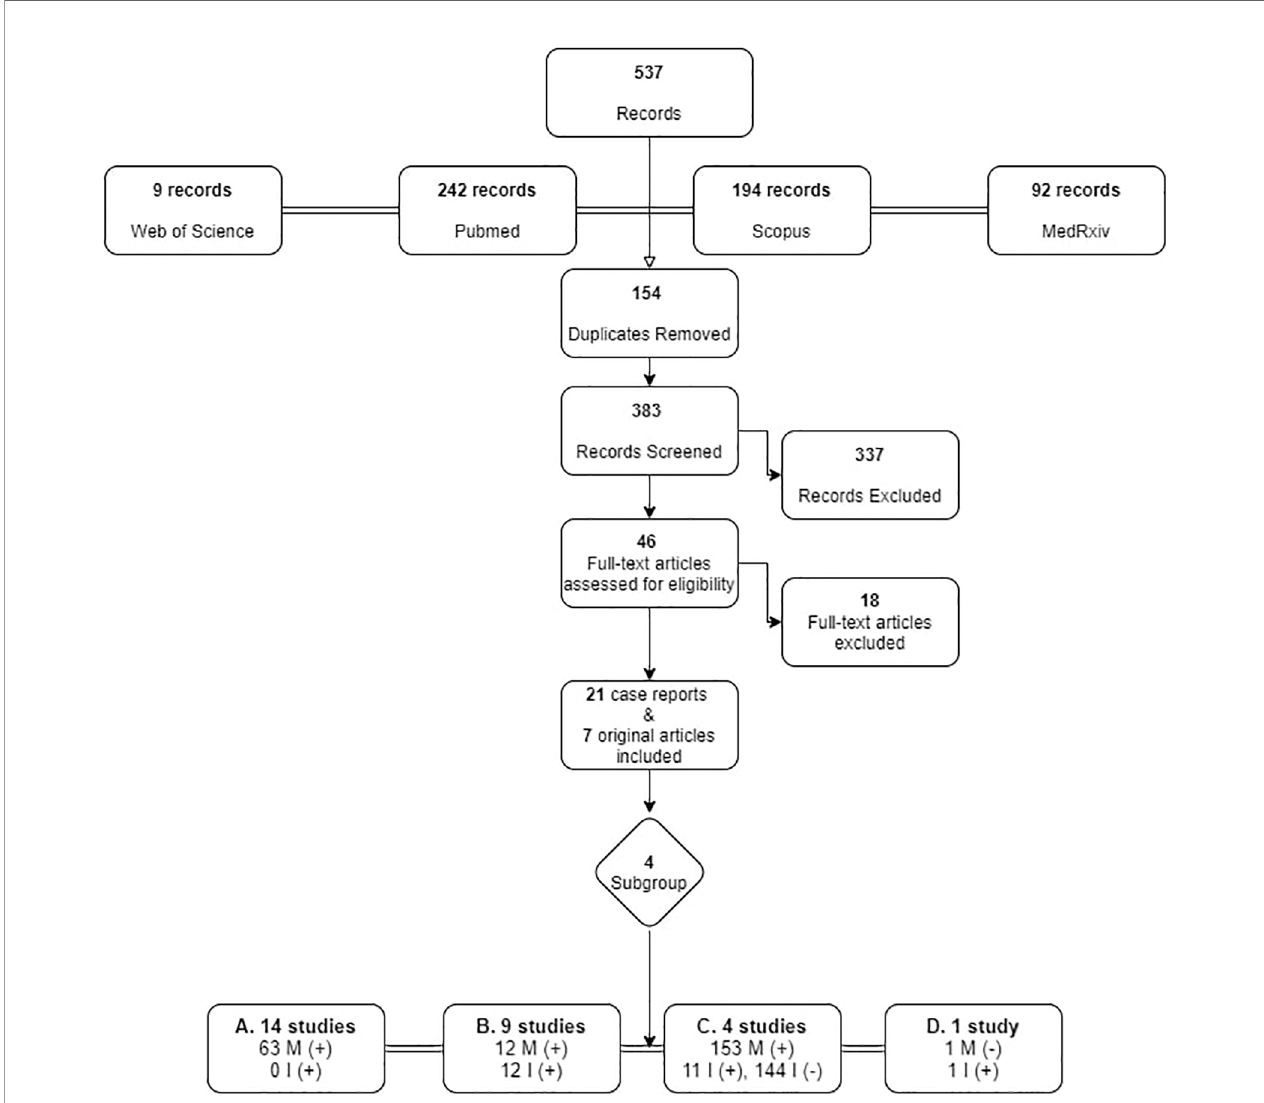
FIGURE 1 | Search strategy fl owchart for original articles on breastfeeding and SARS-Cov-2. M, Mother; I, Infant. +: SARS-CoV-2 infected, -: negative for